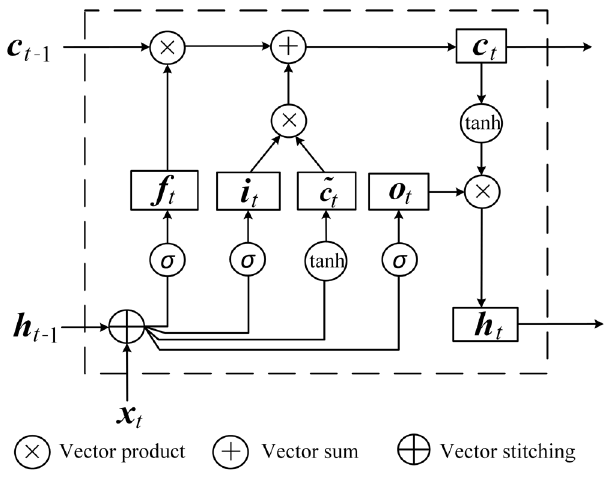
Figure 1. LSTM network structure diagram.